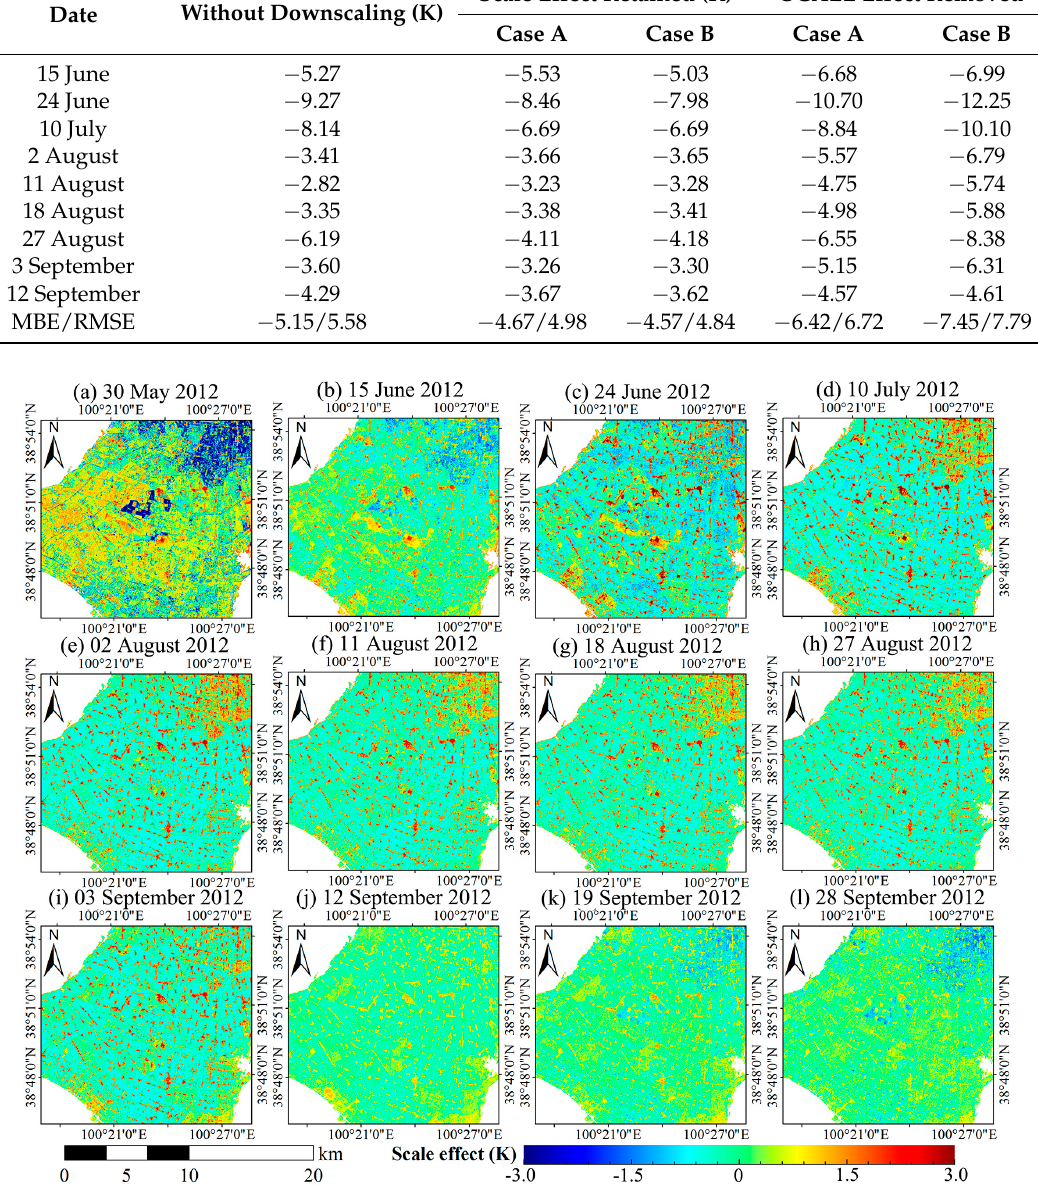
Figure 8. ( a – l ) The estimated scale effects in downscaling ASTER LST with GRM in Case A during the complete crop growing season in the Zhangye oasis.